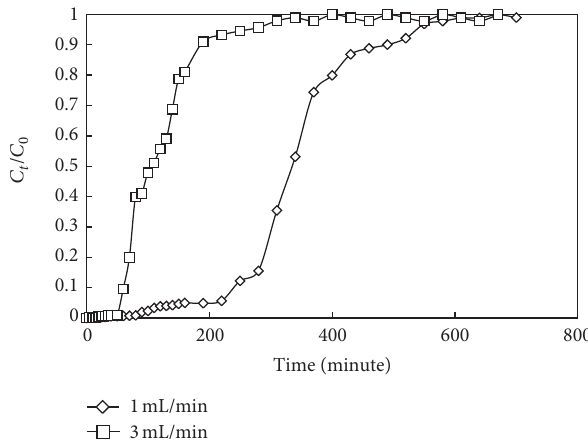
F 4: Breakthrough curves for adsorption of manganese(II) onto MFSAC for different �ow rate (concentration 100mg/L, p� 5.5, temperature